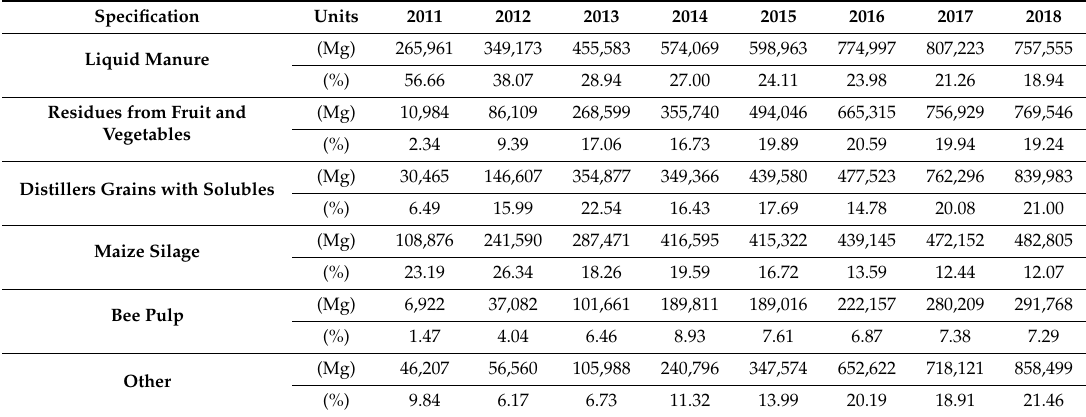
Table 2. Consumption and structure of substrates to produce agricultural biogas in Poland in 2011–2018 [64].